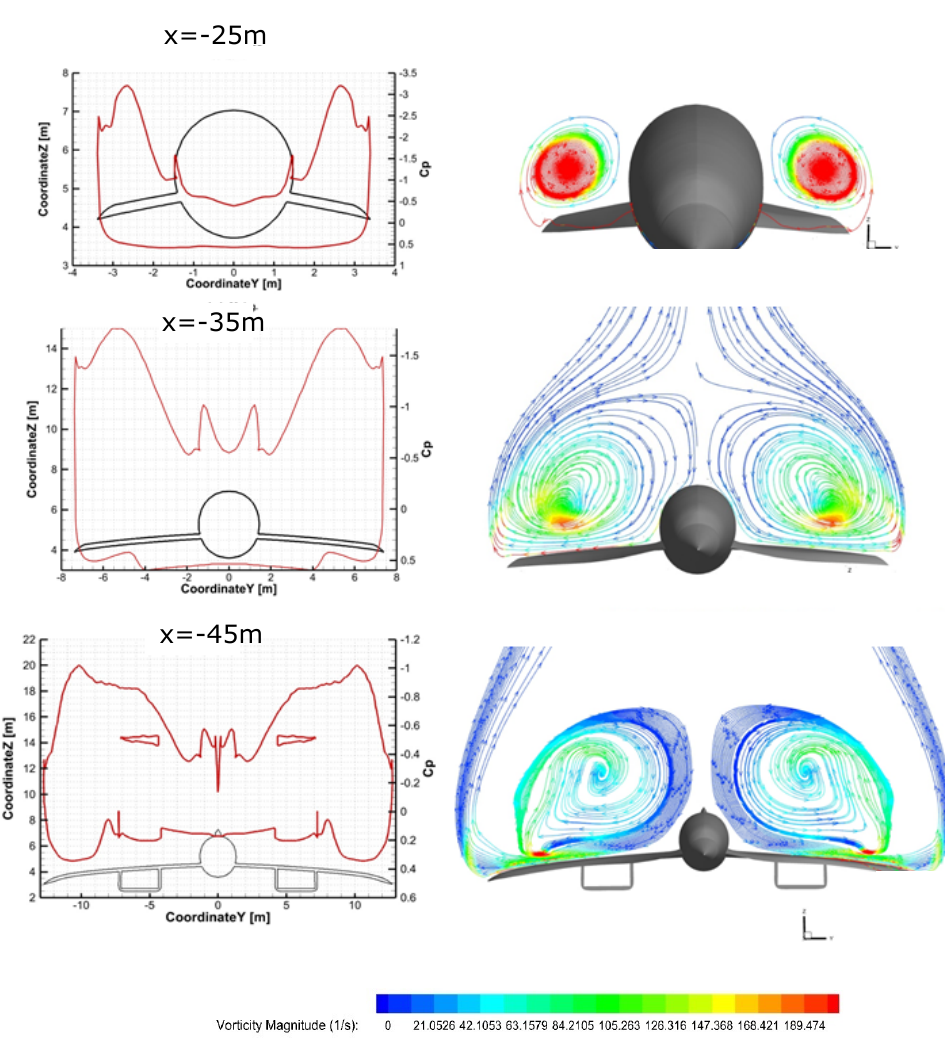
Figure 10. Flowfield results at α = 30 ◦ . Pressure distribution ( left ) and vorticity magnitude ( right ). The VL effect reflects over the aerodynamic performance at about α = 10 ◦ , where the lift coefficient departs from the classical (low-speed) linear trend. Due to VL, C L increases up to α = 30 ◦ , where it takes on its maximum value. Therefore, at a higher AoA, the lift begins to lower, thus highlighting a gentle post-stall condition, as expected. Similarly, the aircraft drag increases according to a quadratic trend until α = 30 ◦ , where there is a change in the slope of the curve due to the VB phenomenon, as expected. Further, CFD and Polhamus’ force coefficients provided in Figure 12c,d are in agreement with each other ( C L and C D at α = 0 ◦ are added to the Polhamus